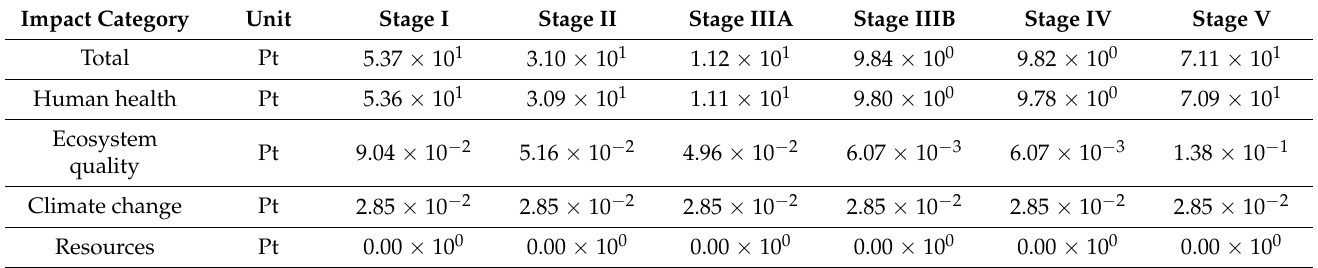
Table 4. Environmental impact of a tractor’s emissions according to its emissions standard.